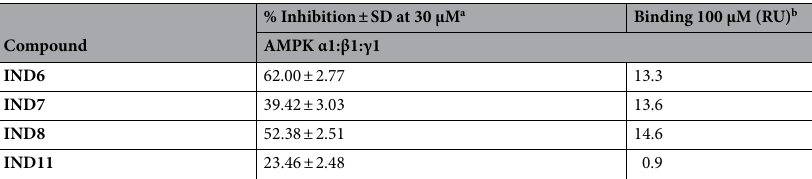
Table 1. AMPK α1:β1:γ1 inhibitory activity and binding results measured by SPR (RU) of indole derivatives. a Data is the mean ± standard deviation (SD) of two independent experiments. Positive control: A-769662: